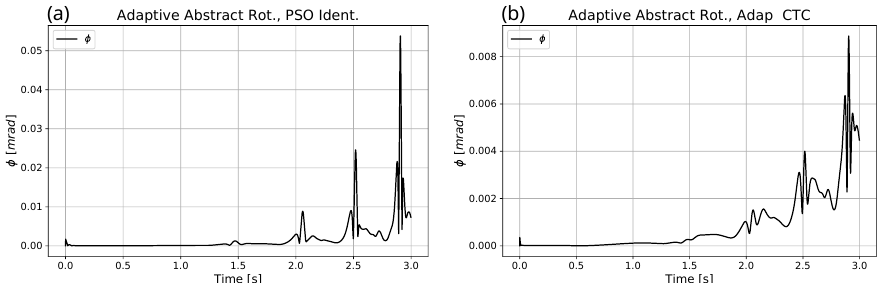
Figure 23. The angle of adaptive abstract rotation during the parameter identification process ( a ), and for the adaptive CTC controller using the identified parameters ( b ).